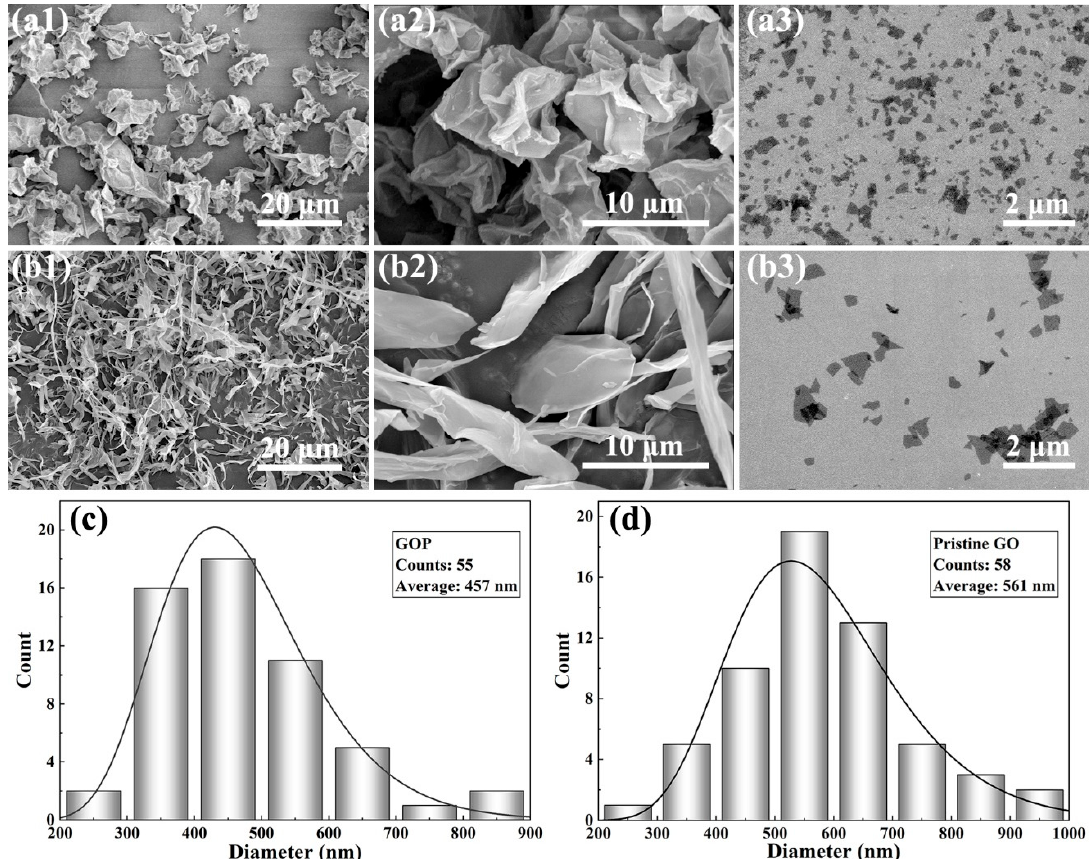
Figure 6. The SEM images of the optimized spray-dried GOP and the pristine GO before ( a1 , a2 , b1 , b2 ) and after ( a3 , b3 ) redispersion. The lateral size histograms of GOP ( c ) and pristine GO ( d ) after redispersion.